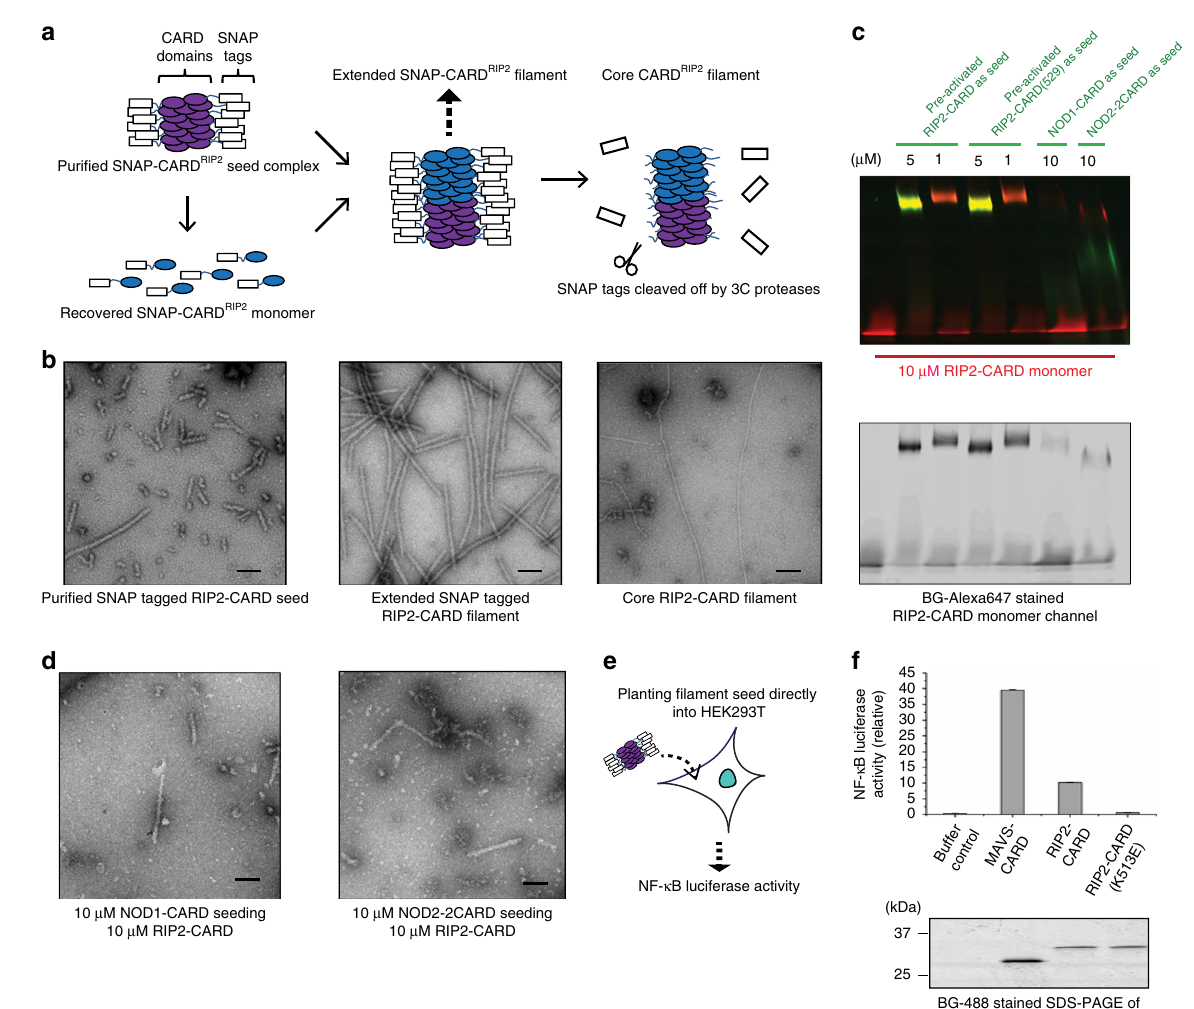
Fig. 3 Preparation of recombinant RIP2 – CARD fi lament in its signaling active form. a Cartoon illustrations showing how recombinant RIP2 – CARD fi laments were prepared. The oligomeric seed fraction of SNAP – RIP2 – CARD was puri fi ed and refolded into functional monomers at resting state. Extended fi laments were prepared by coincubating monomers and seeds together. Once extended fi laments formed, 3C proteases were used to remove the peripheral SNAP fusion tags. The ordered core RIP2 – CARD fi laments were revealed afterward. b Negative stain EM images of SNAP – RIP2 – CARD seeds (left panel), extended SNAP – RIP2 – CARD fi laments (middle panel), and the core RIP2 – CARD fi laments (right panel) at 49,000× magni fi cation. The core RIP2 – CARD fi laments were much thinner (~7 nm) compared to SNAP – RIP2 – CARD fi laments (~11 nm). c Dual-color stained Bis-Tris native gel demonstrating how different seeds, including SNAP – RIP2 – CARD (1 or 5 μ M), SNAP – NOD1 – CARD (10 μ M), and SNAP – NOD2 – CARD (10 μ M), colored in green, triggered the induced oligomerization process of SNAP – RIP2 – CARD (10 μ M) monomers, colored in red. Monomer channel was shown in the lower panel in black and white. d Negative stain EM images showed that 10 μ M RIP2 – CARD proteins were induced to form fi laments by 10 μ M NOD1 – CARD or 10 μ M NOD2 – CARD. Scale bar: 100 nm. e Cartoon illustration of NF- κ B promoter luciferase assay with SNAP – RIP2 – CARD protein seed directly electroporated into the cells. f NF- κ B was activated by intracellular recombinant RIP2 – CARD seeds. SNAP – RIP2 – CARD seeds, SNAP – RIP2 – CARD (K513E) seeds, and MAVS – CARD – SNAP were electroporated into HEK293T cells, together with pGL4.32 NF- κ B-RE vector and CMV- Renilla vectors. Only oligomeric RIP2 protein constructs led to activation of NF- κ B, but not the K513E, the monomeric form of RIP2. MAVS – CARD – SNAP was used as a strong positive control. The same amount of proteins were transfected in each sample. BG-Alexa 488 dye stained SDS-PAGE conferring that the similar level of recombinant seeds were catapulted into the reporter cells. Error bar represents standard deviation values of three independent